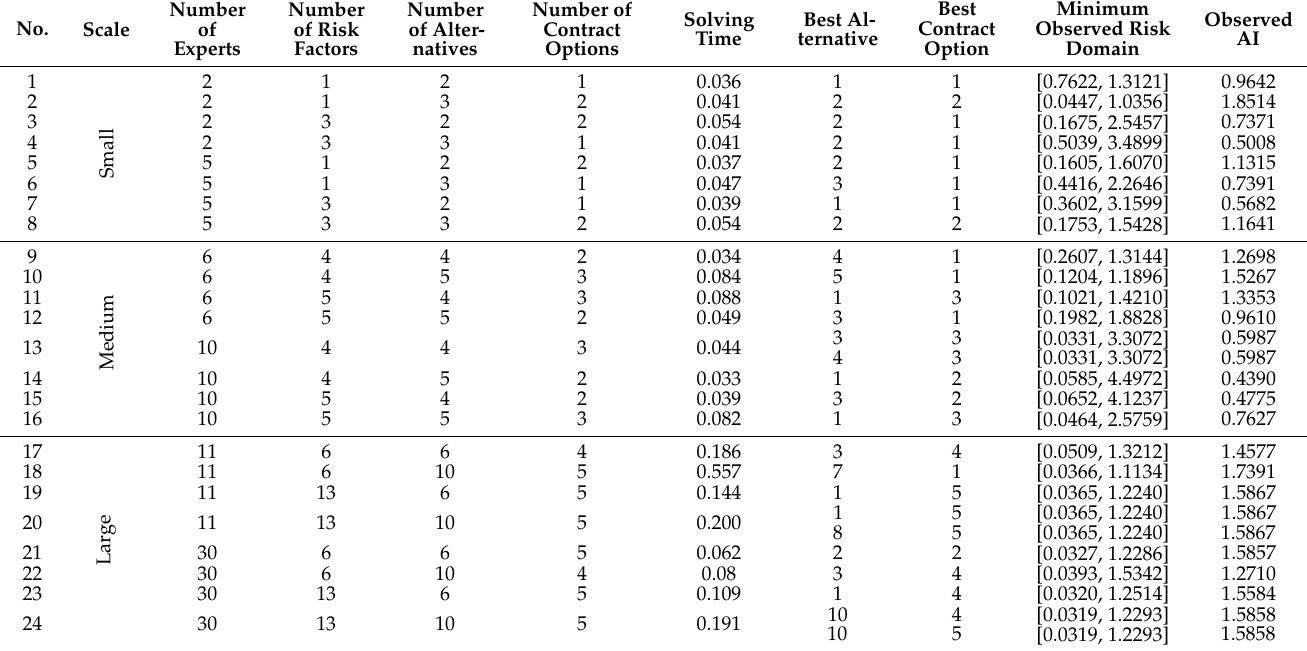
Table 8. Results of solving numerical experiments using the proposed hybrid AHP and theory of evidence algorithm.